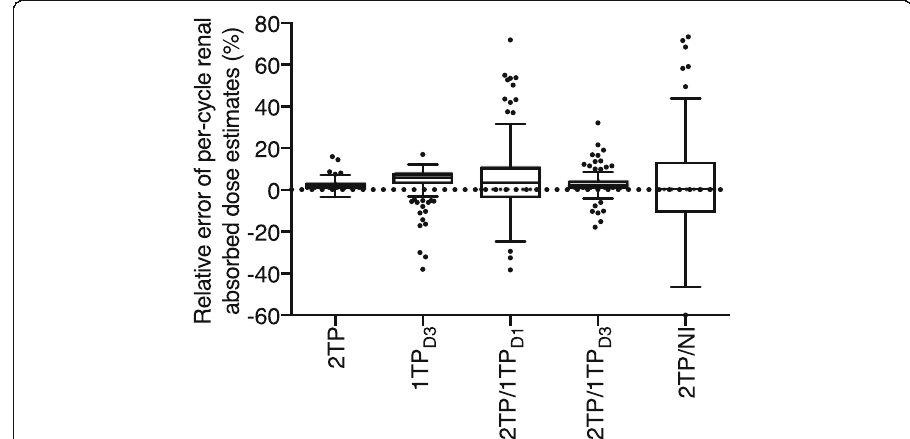
Fig. 3 Comparison of the relative errors of per-cycle renal absorbed dose estimates obtained by the simplified methods relative to the three-time-point (3TP) method. Boxes represent the interquartile range, and whiskers the interdecile range (2TP and 1TP D3 , n = 279; 2TP/1TP D1 , 2TP/1TP D3 , and 2TP/NI, n =